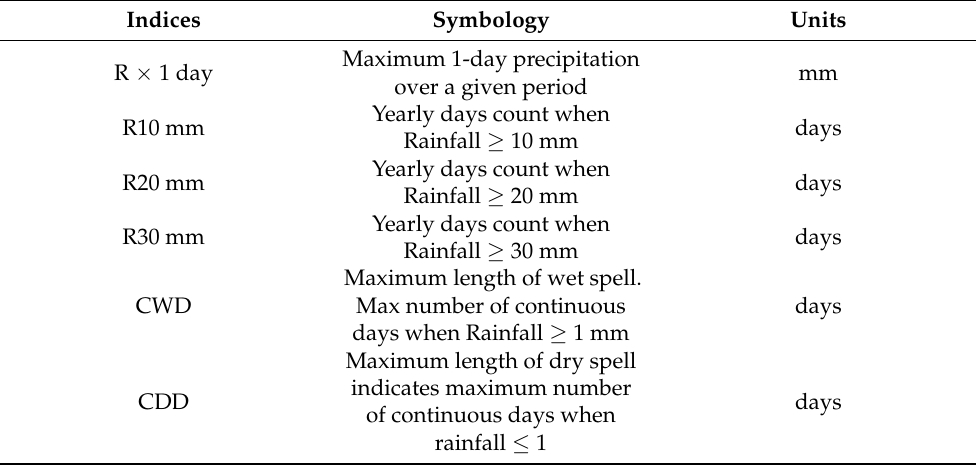
Table 4. Definition of climate indicators used in this study (www.climdex.org, accessed on 11 August